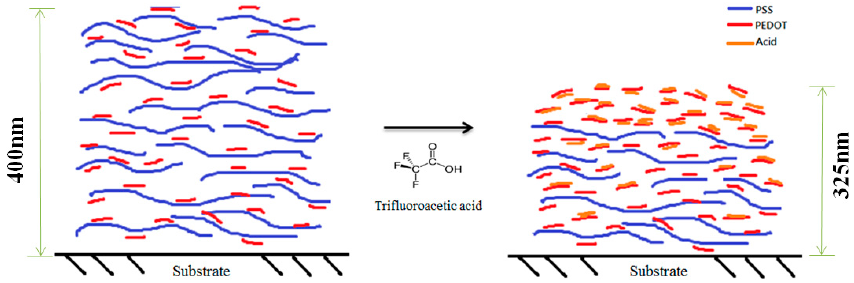
Figure 4. The schematic illustration of the mechanism for conductivity enhancement of PEDOT:PSS films by treatment with organic acid (TFA).